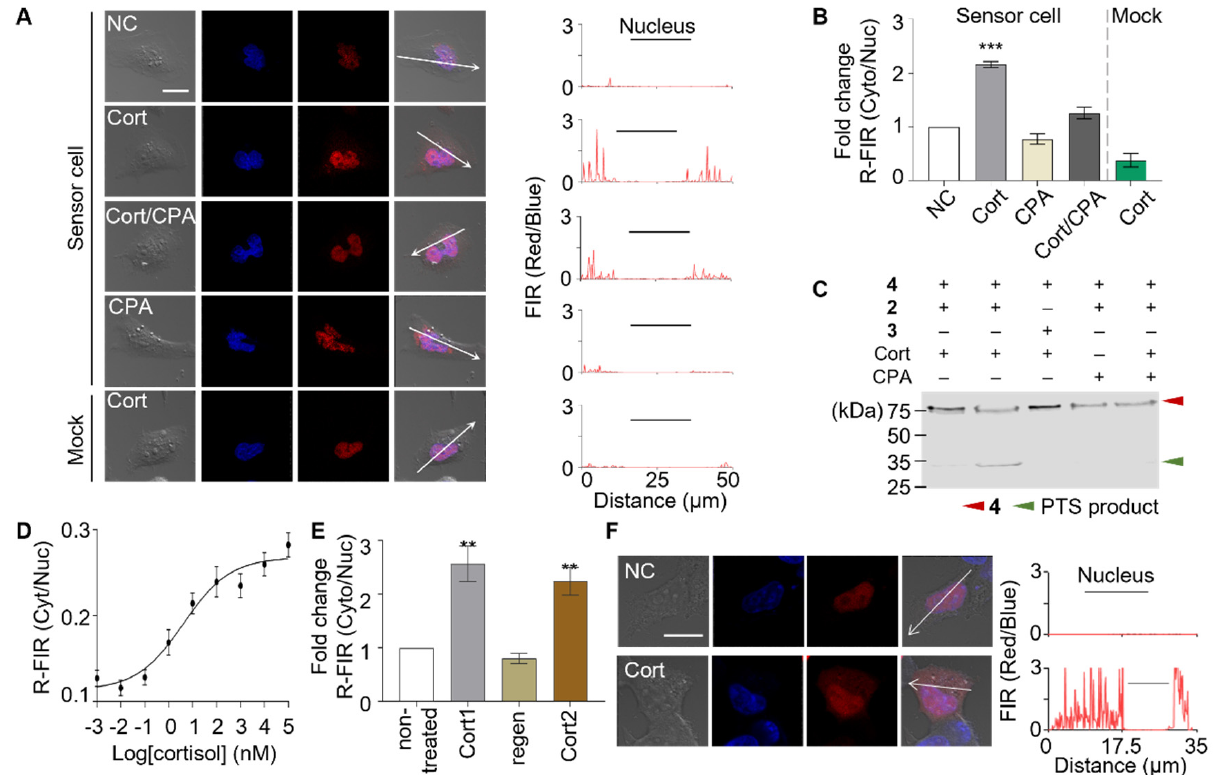
Figure 2. Characterization of cortisol (Cort)-detecting sensor cells. ( A ) Sensor cells co-expressing fusion proteins 1 and 2 exhibited red fluorescence from mCherry in the nucleus prior to stimulation (row 1). The fluorescence signal was translocated to the cytosol upon Cort treatment (row 2). Mock sensors containing fusion proteins 1 and 3 did not respond to Cort (row 3). The passive GR antagonist, CPA, inhibited the Cort-induced signal translocation (row 4 and 5) (scale bar = 20 µ m). ( B ) Fold-change in the ratio of red fluorescence intensities of the cytoplasm to that of the nucleus (R-FIR Cyto/Nuc) over untreated control sensor cells is calculated. Data were analyzed by one-way ANOVA using the Tukey multiple comparison test (* p < 0.05, ** p < 0.01, *** p < 0.001). ( C ) Western blot analysis revealed the formation of reconstituted signal peptides via protein trans-splicing. ( D ) Dose–response of R-FIR Cyto/Nuc signal was plotted and the limit of detection (LOD) was determined to be 1.6 nM. ( E ) The Cort-treated sensor cells were spontaneously regenerated and used multiple times to detect Cort without a notable loss of function. ( F ) HEK293T cell-derived sensor cells were treated with Cort and exhibited fluorescence signal translocation.